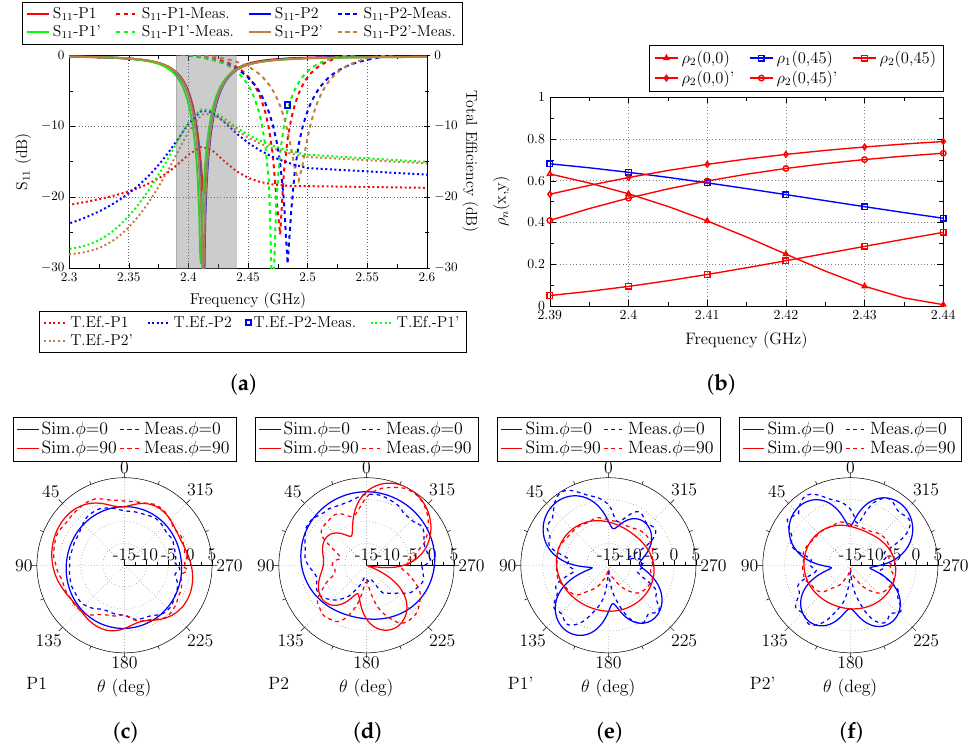
Figure 9. ( a ) Reflection coefficient (S 11 ) and total efficiency (dB) of the antenna located at the four analyzed positions (the frequency band colored in gray corresponds to the operating band analyzed with the correlation), ( b ) Correlation (detailed in Equation (3)) of total and modal fields, and radiation patterns at ( c ) P1(x,y) = (0,0), ( d ) P2(x,y) = (0,45), ( e ) P1’(x,y) = (0,0) and, ( f ) P2’(x,y) =